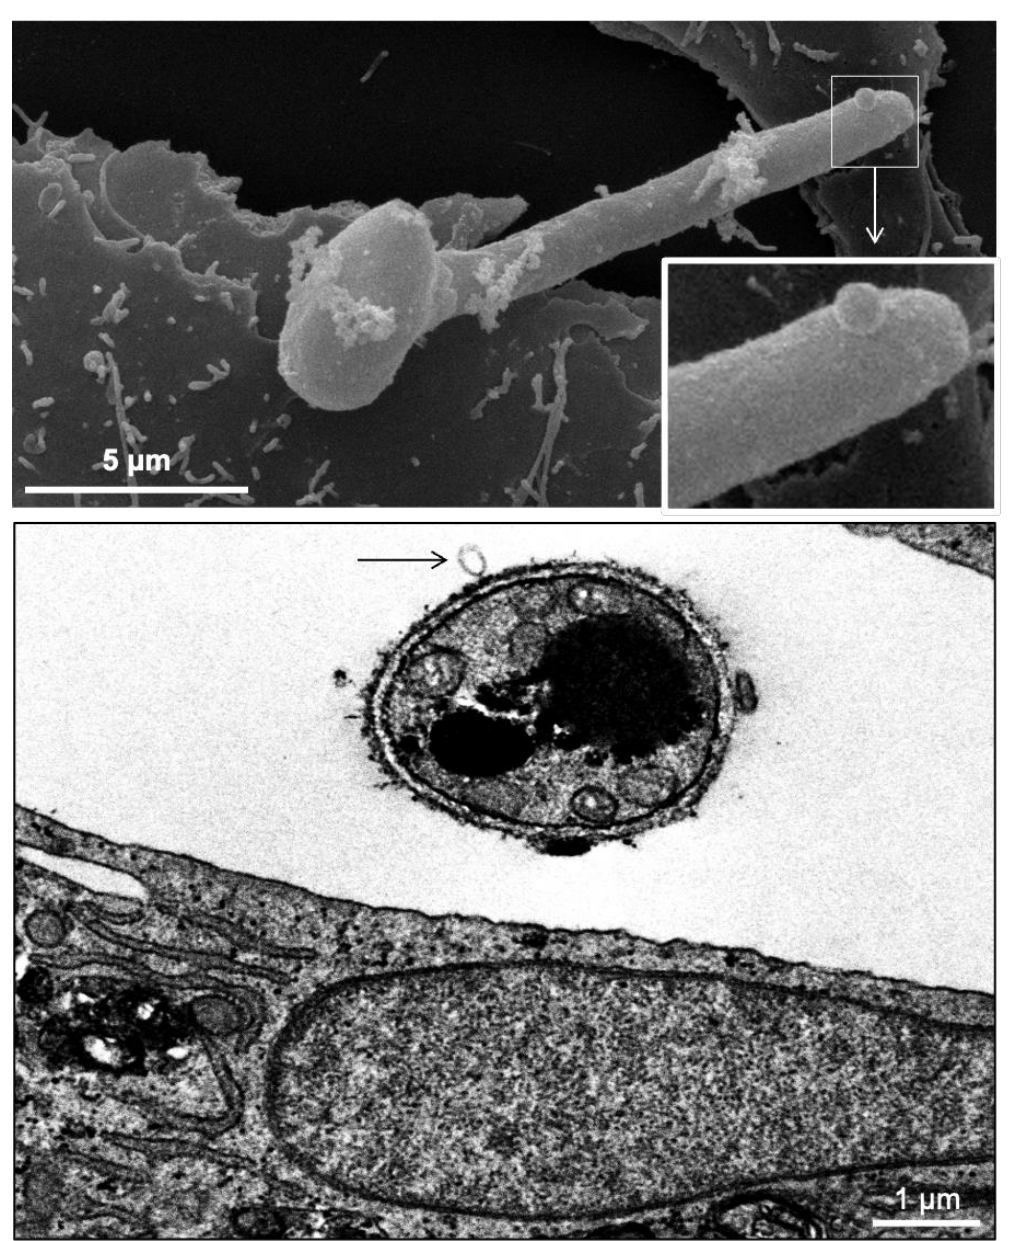
( A ) TEM images demonstrated the presence of vesicles within a membrane invagination in S. minutisporum hyphae. The black circle evidences the invagination. Bar: 1 µ m. ( B , C ) TEM mi- crographs showing vesicle bodies in the extracellular milieu of S. apiospermum hyphae. Arrows evidence the vesicular bodies. cw, cell wall. Bar: 250 nm. ( D ) TEM image of S. apiospermum conidia. The black circle evidences the membrane invagination, and the arrow evidences the vesicular bodies. Cw, cell wall. Bar: 1 µ m.